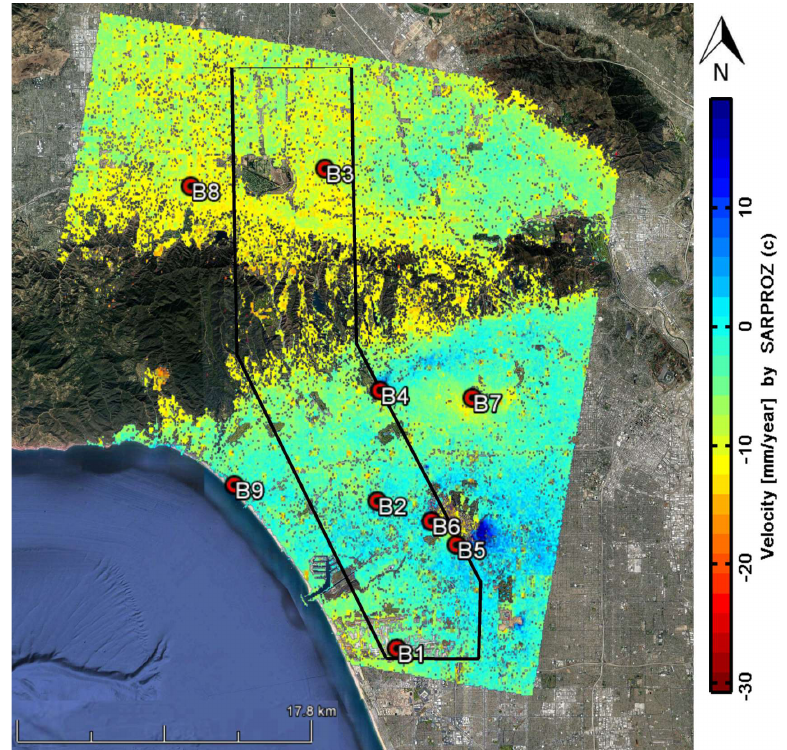
Figure 11. The location of Lithological